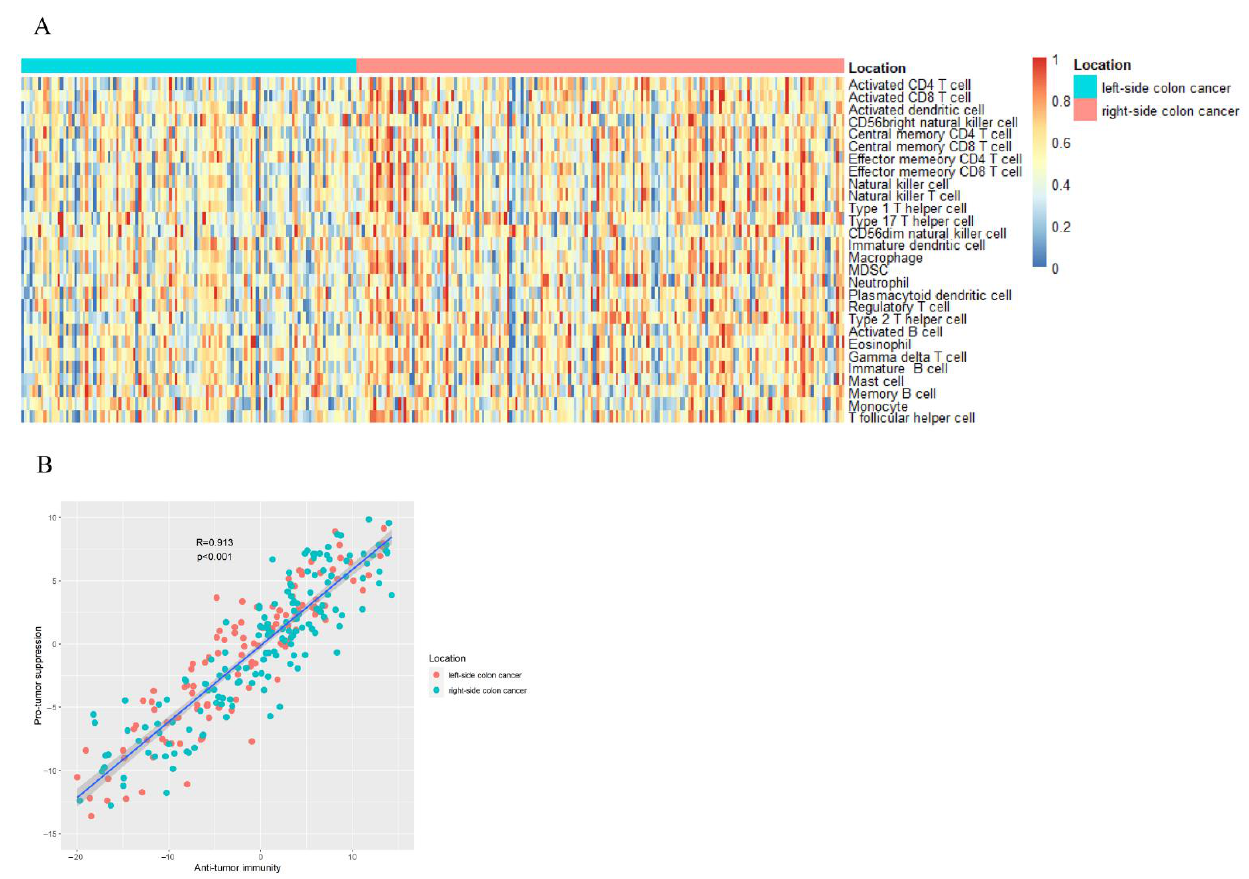
Figure 1. ( A ) An analysis of gene set enrichment using single-sample samples identifies the relative recruitment of immune cells in tumor tissues from different sides of colon cancer. A z-score is calculated based on the relative infiltration of each cell type. ( B ) Relationship between infiltration of anti-tumor immune cells (ActCD4, ActCD8, TcmCD4, TcmCD8, TemCD4, TemCD8, Th1, Th17, ActDC, CD56briNK, NK, and NKT) and their pro-tumor immunosuppressive counterparts (Treg, Th2, CD56dimNK, imDC, TAM, MDSC, neutrophil, and pDC). In Pearson ’ s correlation, R is the correlation coefficient. Approximately 95% of the shaded area represents a confidence interval.